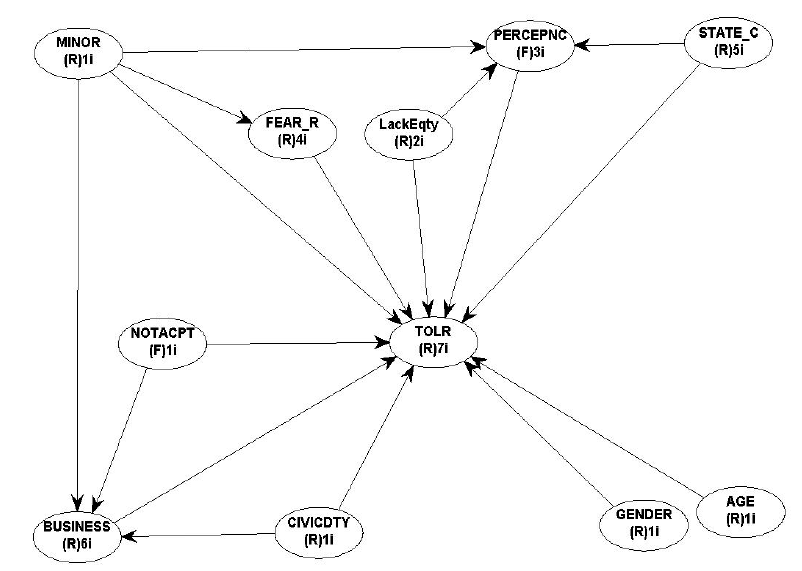
Figure 1. The research model.